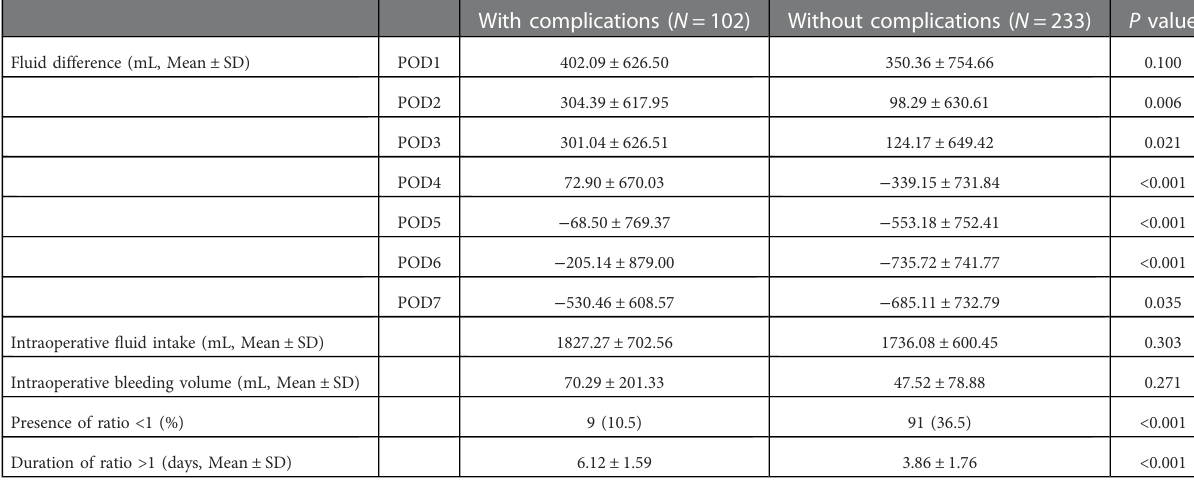
TABLE 3 Perioperative fl uid volume in patients with or without complications.